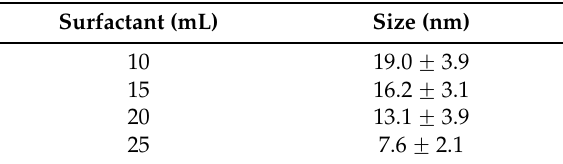
Figure 1. Transmission electron microscopy image of n-octylamine-coated iron oxide nanoparticles. A spherical shape is observed with a size of ( a ) 13.1 ± 3.9 nm ( b ) 16.2 ± 3.1 nm and ( c ) 19.0 ± 3.9 nm. Table 1. Influence of the amount of surfactant on the size of the iron oxide nanoparticle. 10, 15 and 20 mL n-octylamine were tested and compared to the 7.6 nm iron oxide nanoparticles described by Brullot et al.